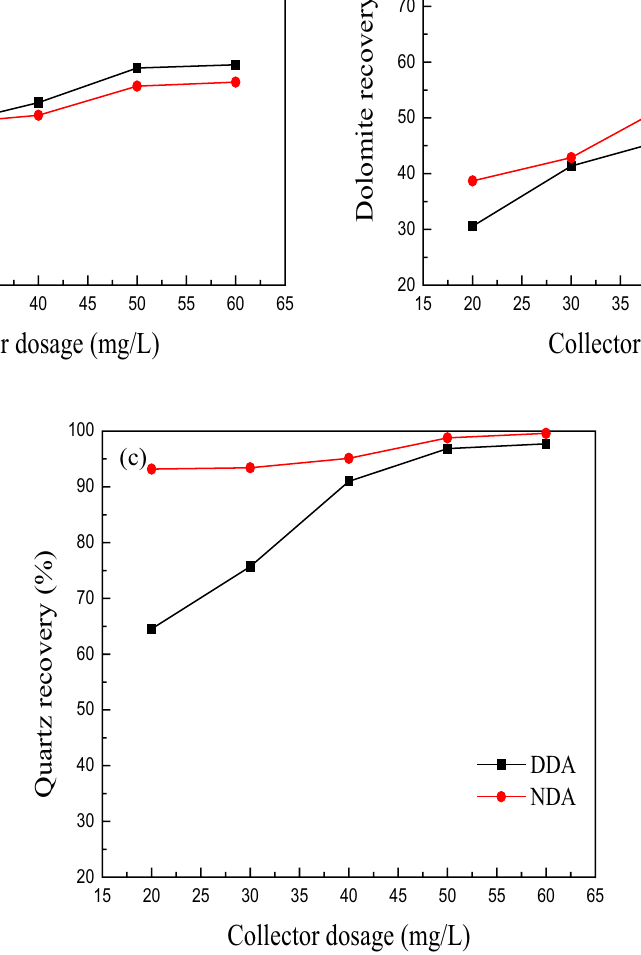
Figure 2. The effect of n -octanol on the flotation of magnesite ( a ), dolomite ( b ) and quartz ( c ) with dodecylamine ( DDA dodecylamine, NDA dodecylamine + n